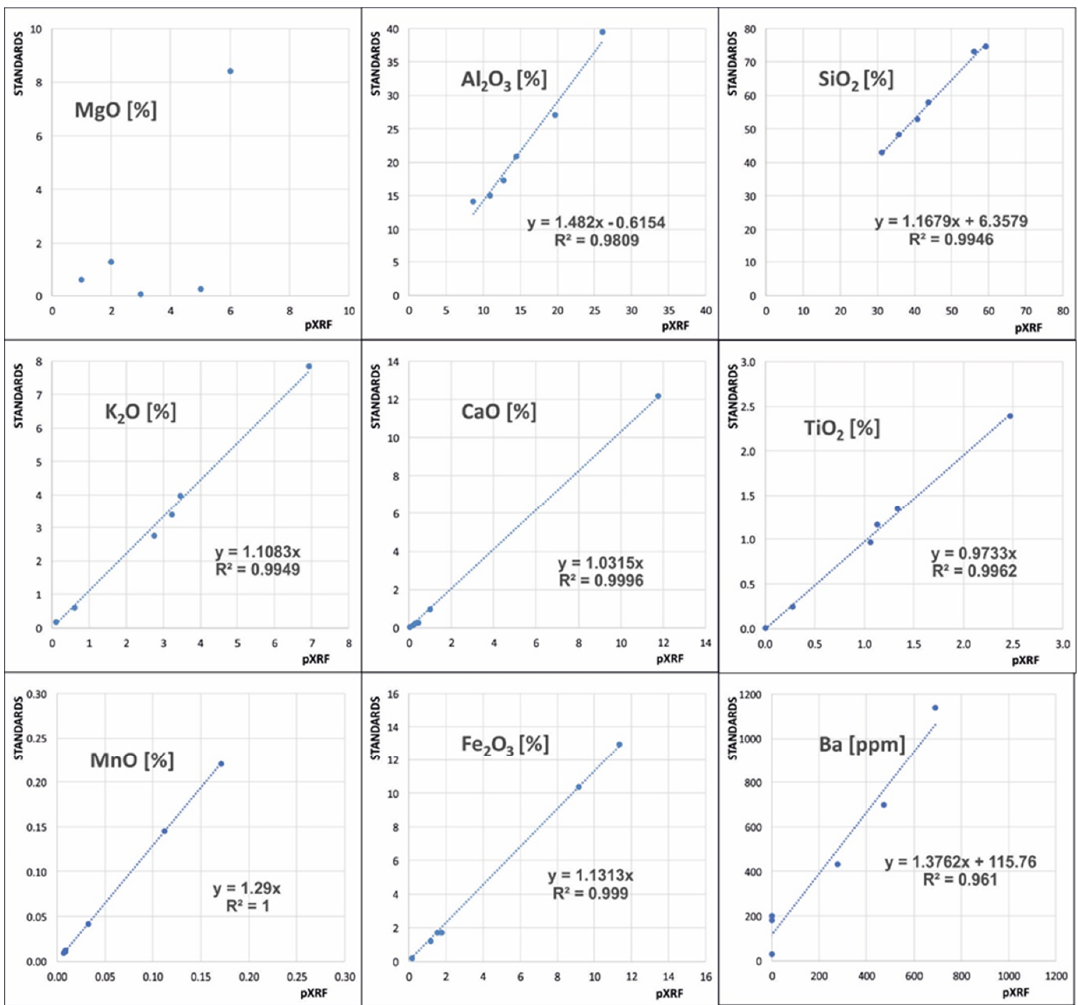
Figure 3. Correlation of chemical analysis results obtained with the use of a portable pXRF spectrometer with certified values of the NIST standards.